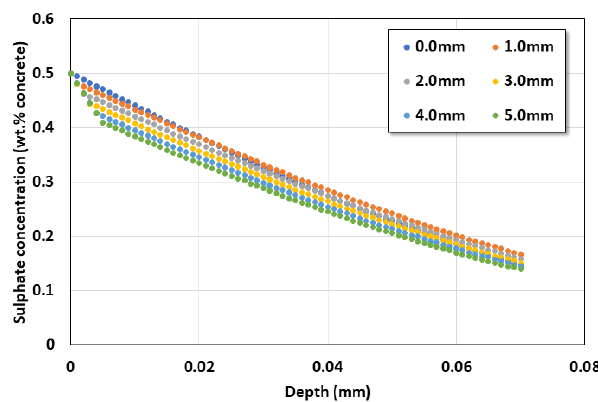
Figure 8. Sulfate ion profile after 50 years. 221